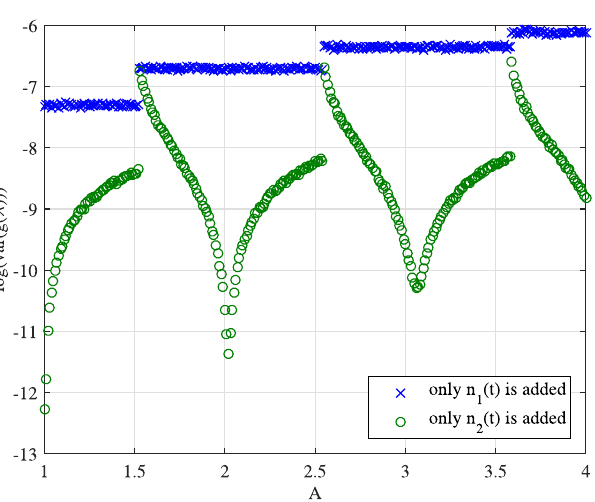
Figure 9. Eigenvalue perturbation errors when n 1 ( t ) and n 2 ( t ) are added separately.